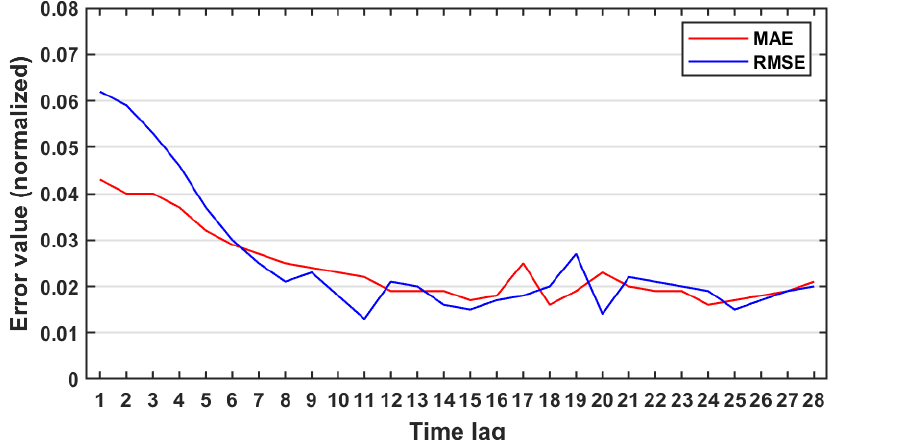
Figure 8. MAE and RMSE of LSTM output with time-lag values in range (1:28).